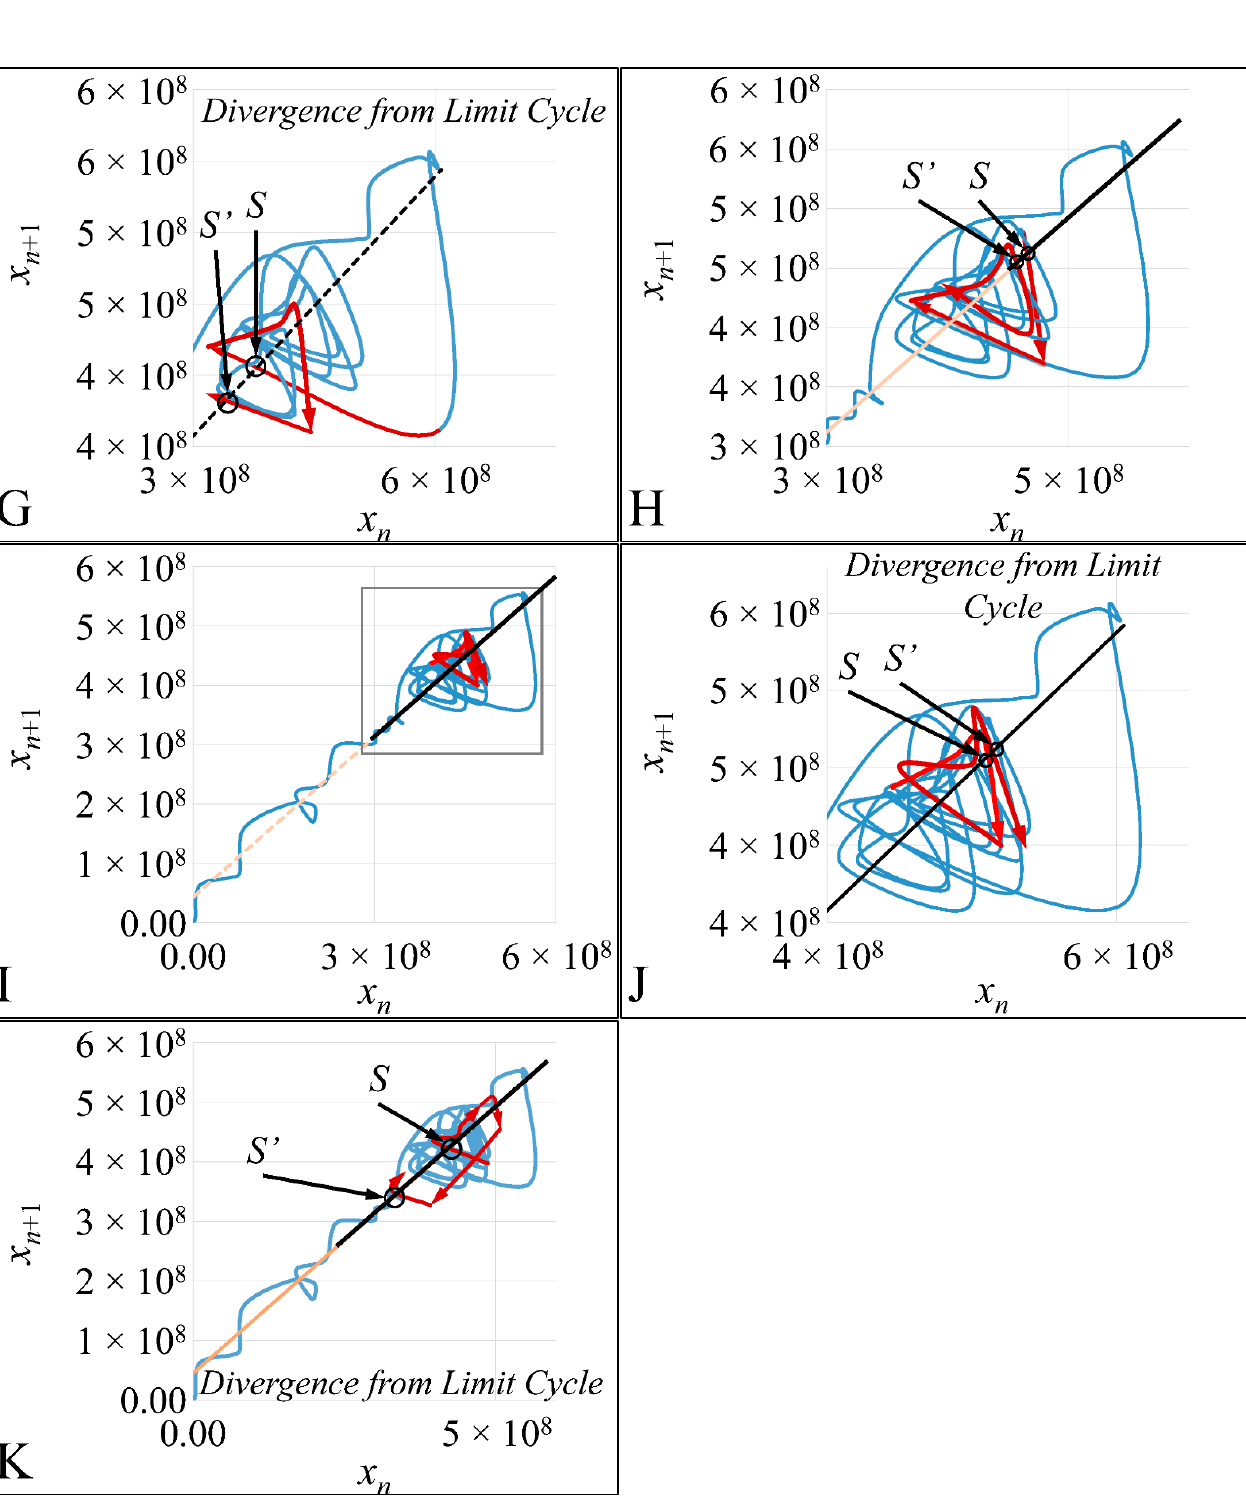
Figure 12. The phase-space of the experiment for x 0 = 20 cells/ μ L. The red arrows indicate the course of the trajectory step-by-step. In addition, in all subfigures the diagonal is drawn, which shows the Poincaré map crossings. The x -axis corresponds to the population of cells at time t and the y -axis corresponds to the population of cells at time t + 1. The system converged in the first convolution of the trajectory ( A , B ) as well as after cell culture media supplementation ( E ). In the other cases ( C , D , F – K ) diverged from equilibrium.